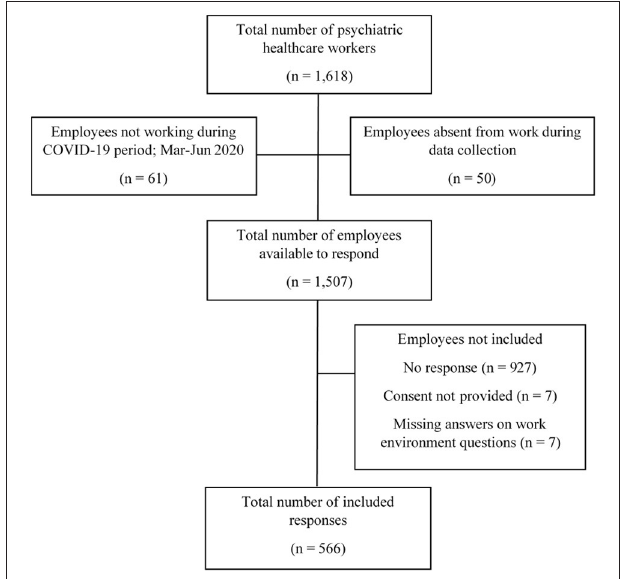
FIGURE 1 | Response flowchart to online survey administered to psychiatric healthcare workers in 2020.